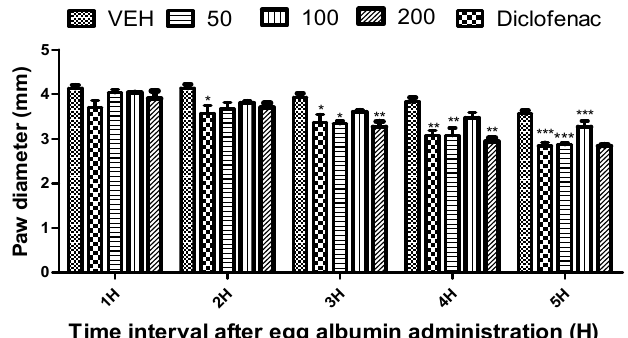
Figure 1. Effect of “White Marsh” grapefruit ( C. paradisi ) fresh peel essential oil on egg albumin- induced rat paw oedema. Results are expressed as Mean ± SEM. VEH, ECH and ASA represent vehicle (5% Tween 80), Marsh peel essential oil (FMPG) and diclofenac, respectively. ** p < 0.01, *** p < 0.001, statistically different from negative control group (ANOVA, Dunnett’s).